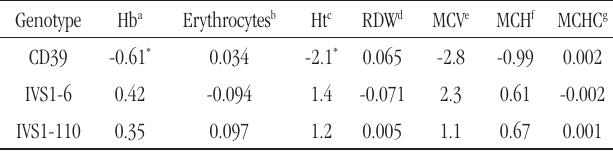
taBLE 3 − Multivariate linear regressions between genotypes and hematological parameters Genotype